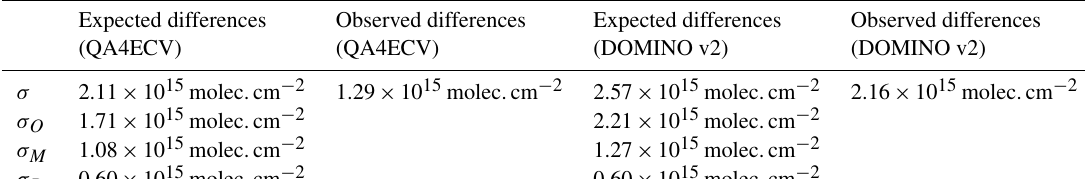
Table 7. Expected and observed differences between OMI and MAX-DOAS NO 2 columns observed over Tai’an in June 2006 for the QA4ECV ( n = 31) and DOMINO v2 ( n = 45) ensemble. Summary of uncertainties for the all (31 or 45) matching pixels. σ O (reported OMI uncertainty) and σ M (reported MAX-DOAS uncertainty) are the mean of 31 or 45 individual values, and σ R is considered to be a 10% contribution from mismatches.